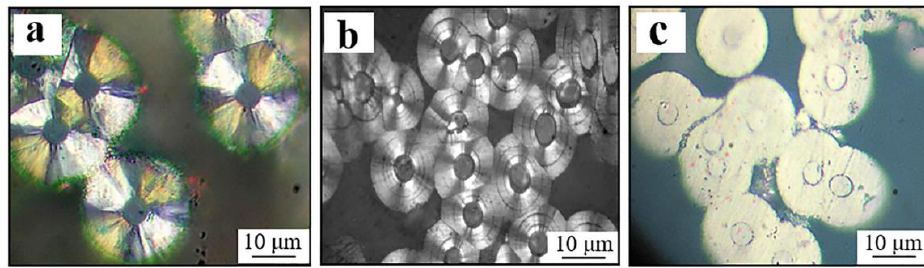
Figure 4. Microstructures of the pyrolytic carbons through a polarized light microscope: ( a ) rough layer; ( b ) smooth layer; ( c ) isotropic layer. Table 2. Properties of pyrolytic carbon with different structures.